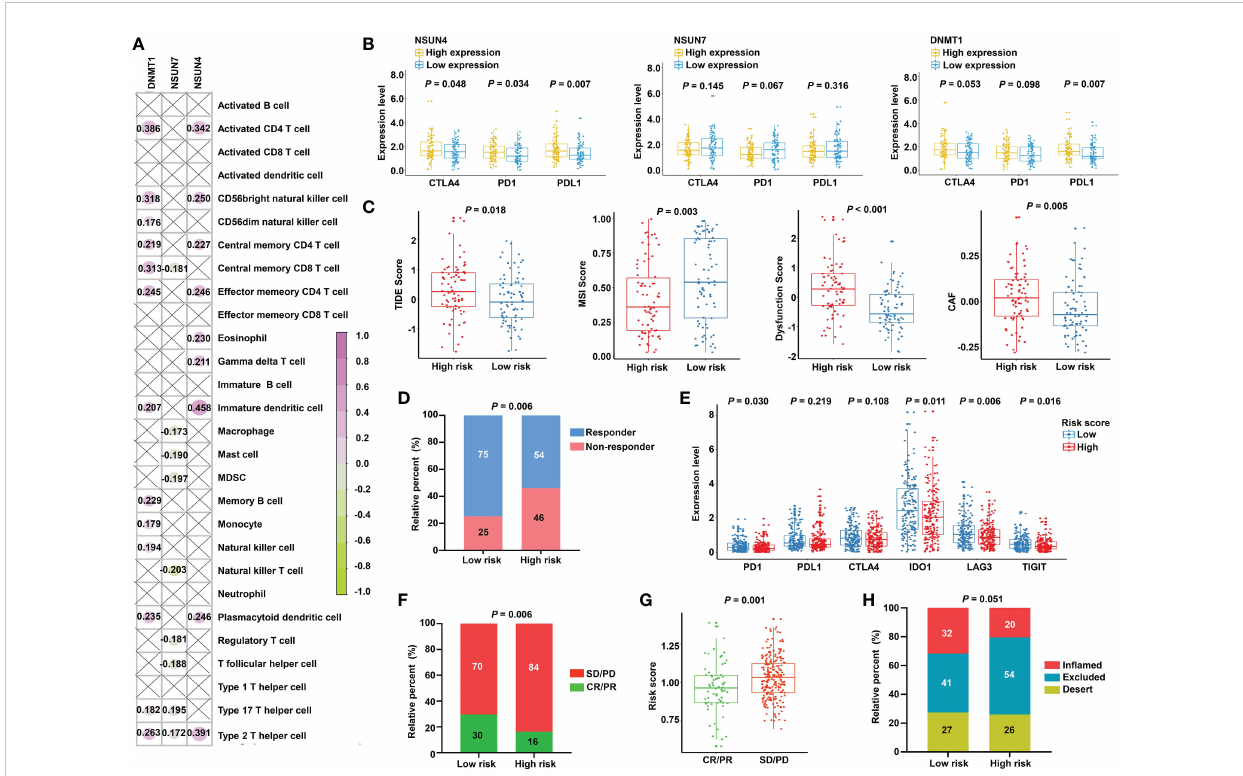
FIGURE 8 Prediction of immunotherapeutic response for distinct subgroups in READ. (A) Pearson correlation between three signature factors and 28 types of immune cells is illustrated by a correlation heat map. Correlations with P value > 0.05 are marked by a cross. (B) The differences in the three signature factors between distinct subgroups classi fi ed by the expression level of three immune checkpoints, including CTLA4, PD1, and PDL1. (C) The distribution of TIDE score, MSI score, T-cell dysfunction score, and abundance of CAF between the low- and high-risk categories. (D) The proportion of READ patients with response to ICI therapy in the high- and low-risk groups based on TIDE prediction. (E) The differential analysis for immune checkpoints between the two categories in IMvigor210 cohort. (F) The proportion of patients with response to PD-L1 treatment in the high- and low-risk groups based on IMvigor210 cohort. (G) Distribution of the risk score between CR/PR and SD/PD groups. (H) The proportion of immune phenotype in the high- and low-risk groups. CR, complete response; PD, progressive disease; PR, partial response; SD, stable